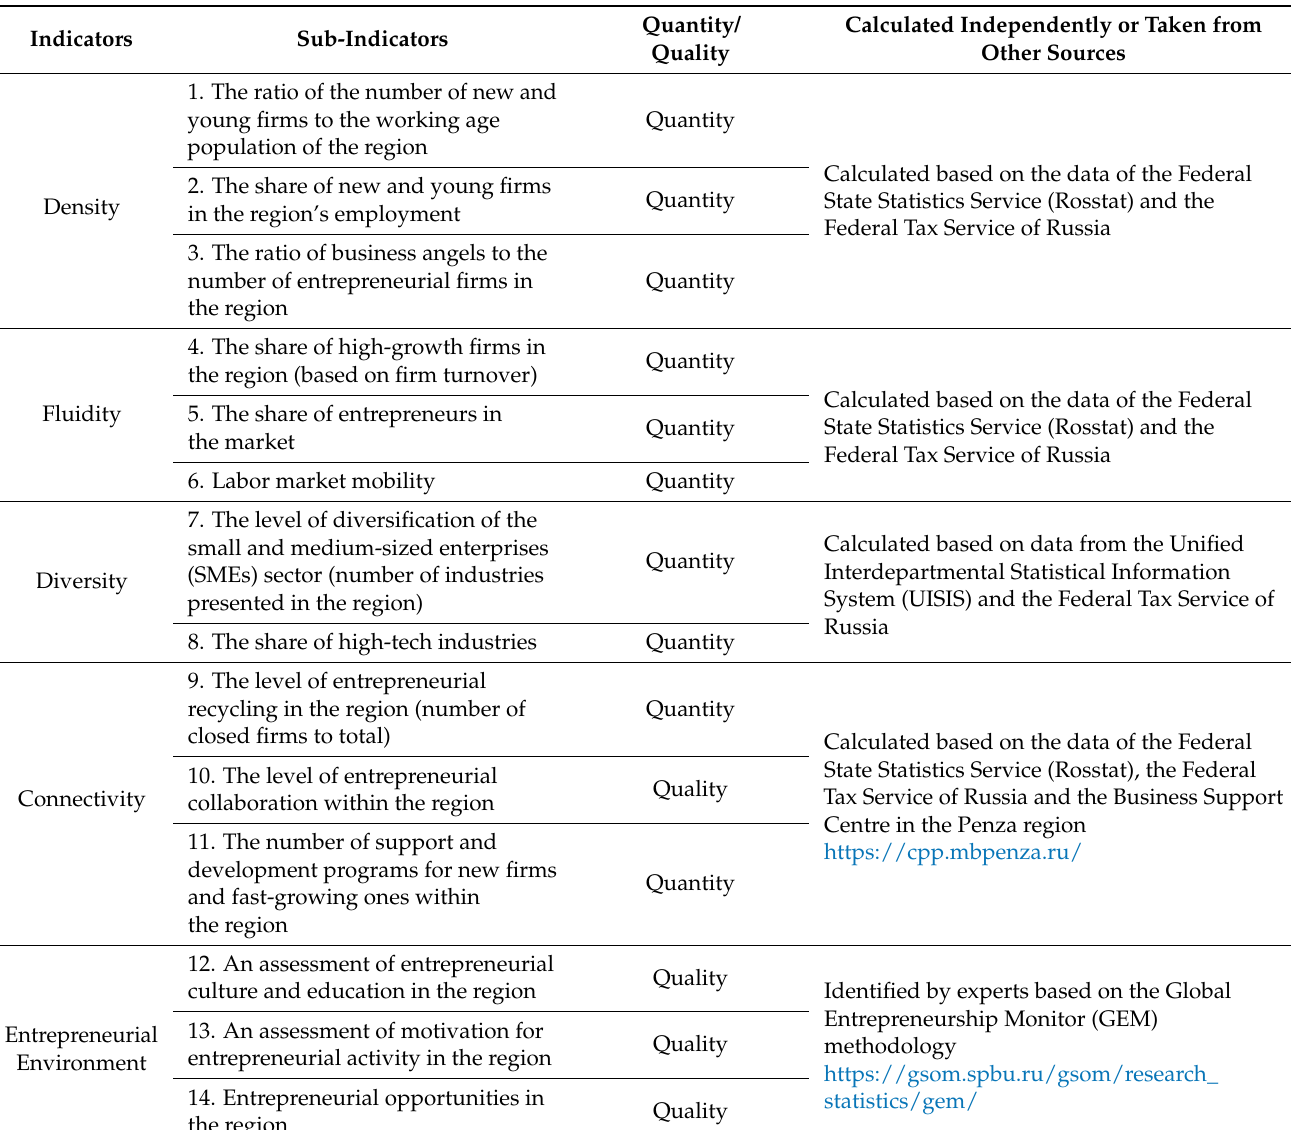
Table 2. Indicators for assessing ecosystem